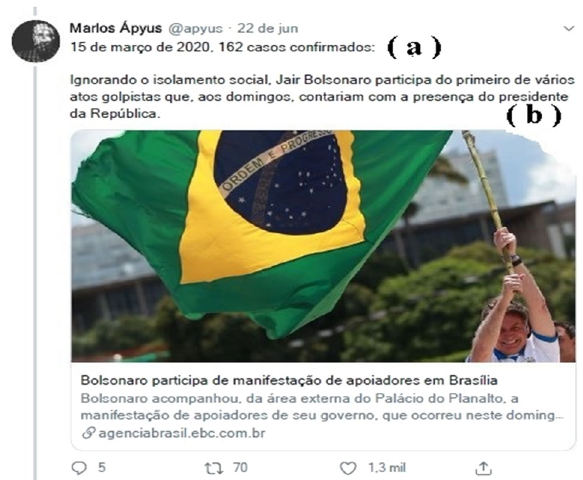
Fig. 4 On Twitter, a journalist ’ s commentary on Bolsonaro ’ s conduct, his supporters and social distancing. Translation (a): 15 March, 2020: 162 con fi rmed cases. Translation (b): Ignoring social distancing, Jair Bolsonaro takes part in the fi rst of many self-coup-motivated street demonstrations in which, on Sundays, the president of the Republic would be